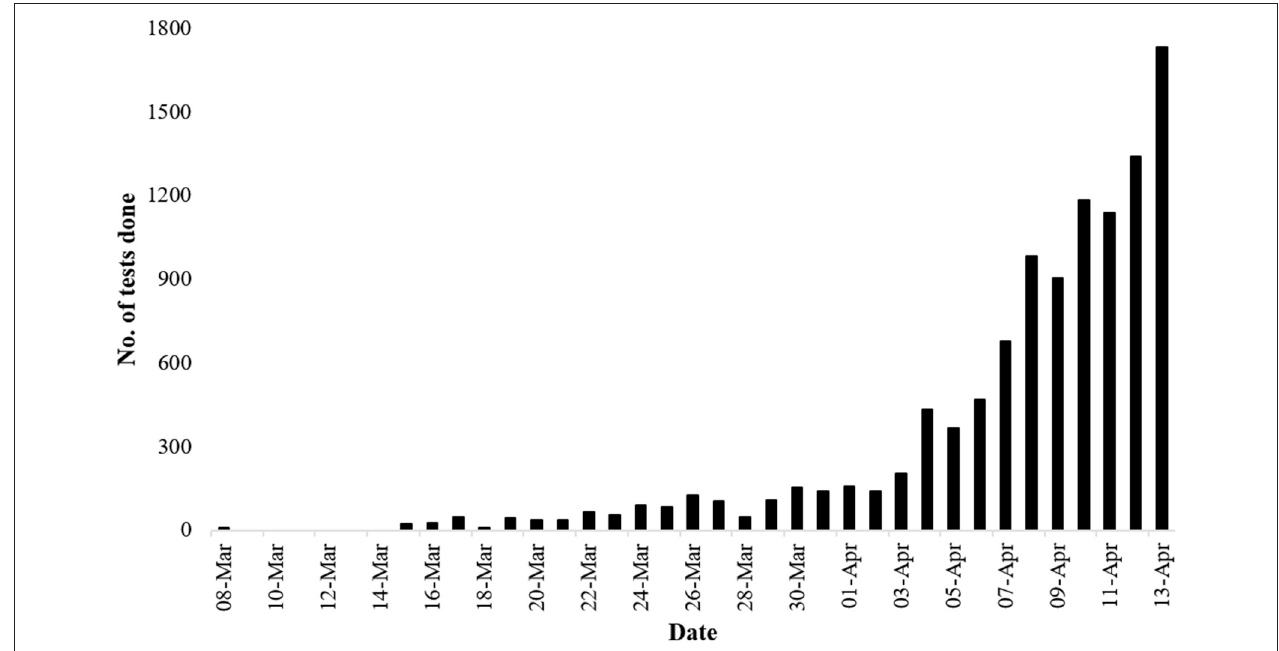
FIGURE 2 | Number of tests done daily. The rate of testing rose significantly 4 weeks after the identification of the first case of COVID-19 in the country